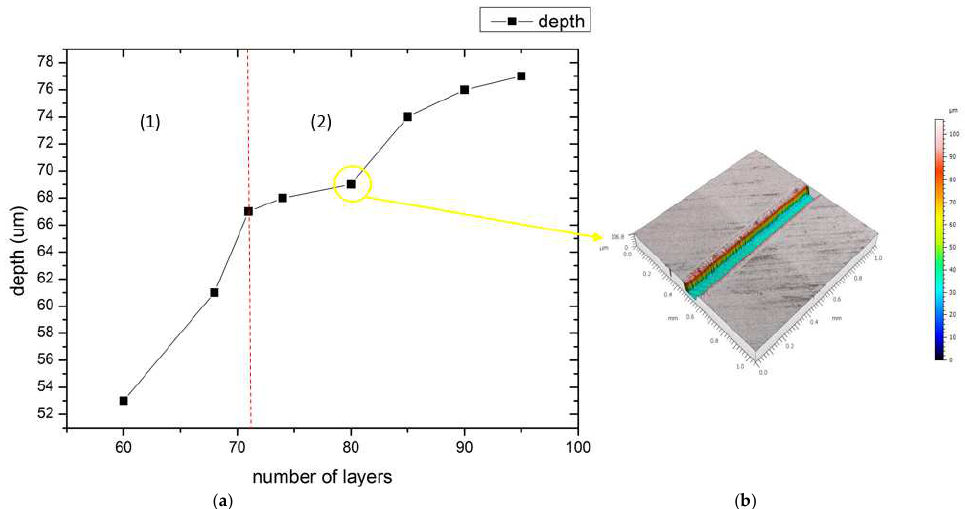
Figure 6. ( a ) Effect of the number of laser scanning layers on the ablation depth of microgrooves. (1) and (2) are the two different regions where the ablation depth of the micro groove varies with the number of laser scanning layers. ( b ) The inset represents the 3D morphology of the microgroove at 80 layers of laser scanning.